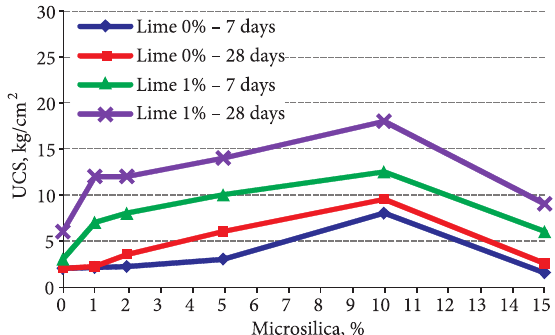
Fig. 11. Changes in unconfined compressive strength of dry samples containing 1% of lime with different percentages of Microsilica